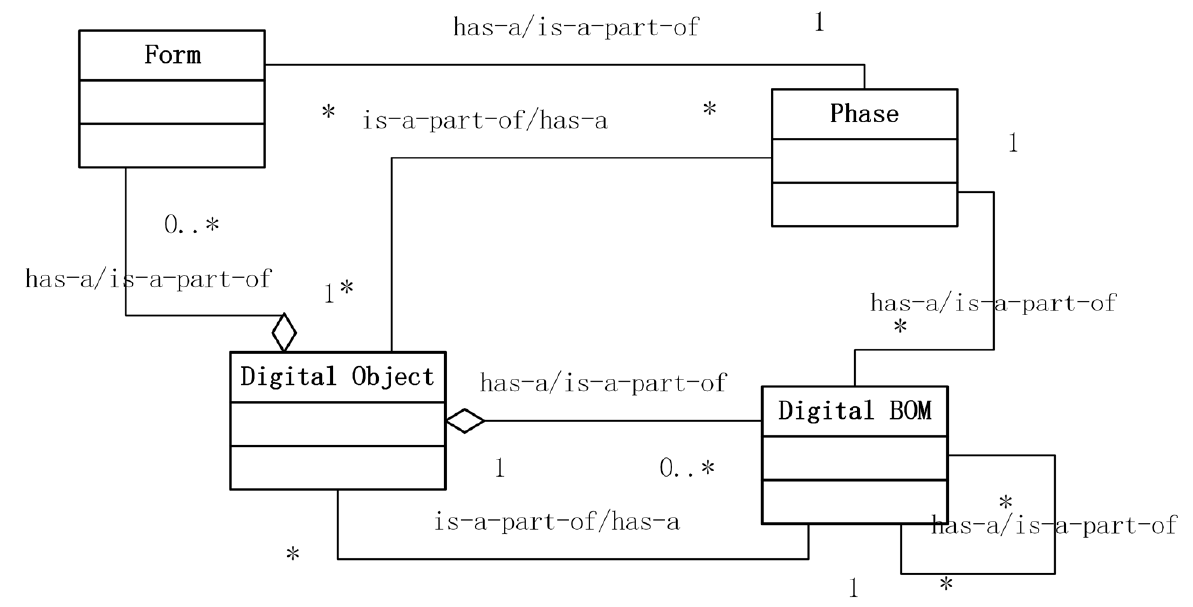
Figure 5. Digital Core Data Model (1, * represent the one and multi-object) Rule filter uses a set of rules to restrict objects, relations and access. The attributes of the rules are shown in Table 4. ID is the identification number. The name is used to indi- cate the meaning of a rule. Phase decides the business phase. Priority means the order of